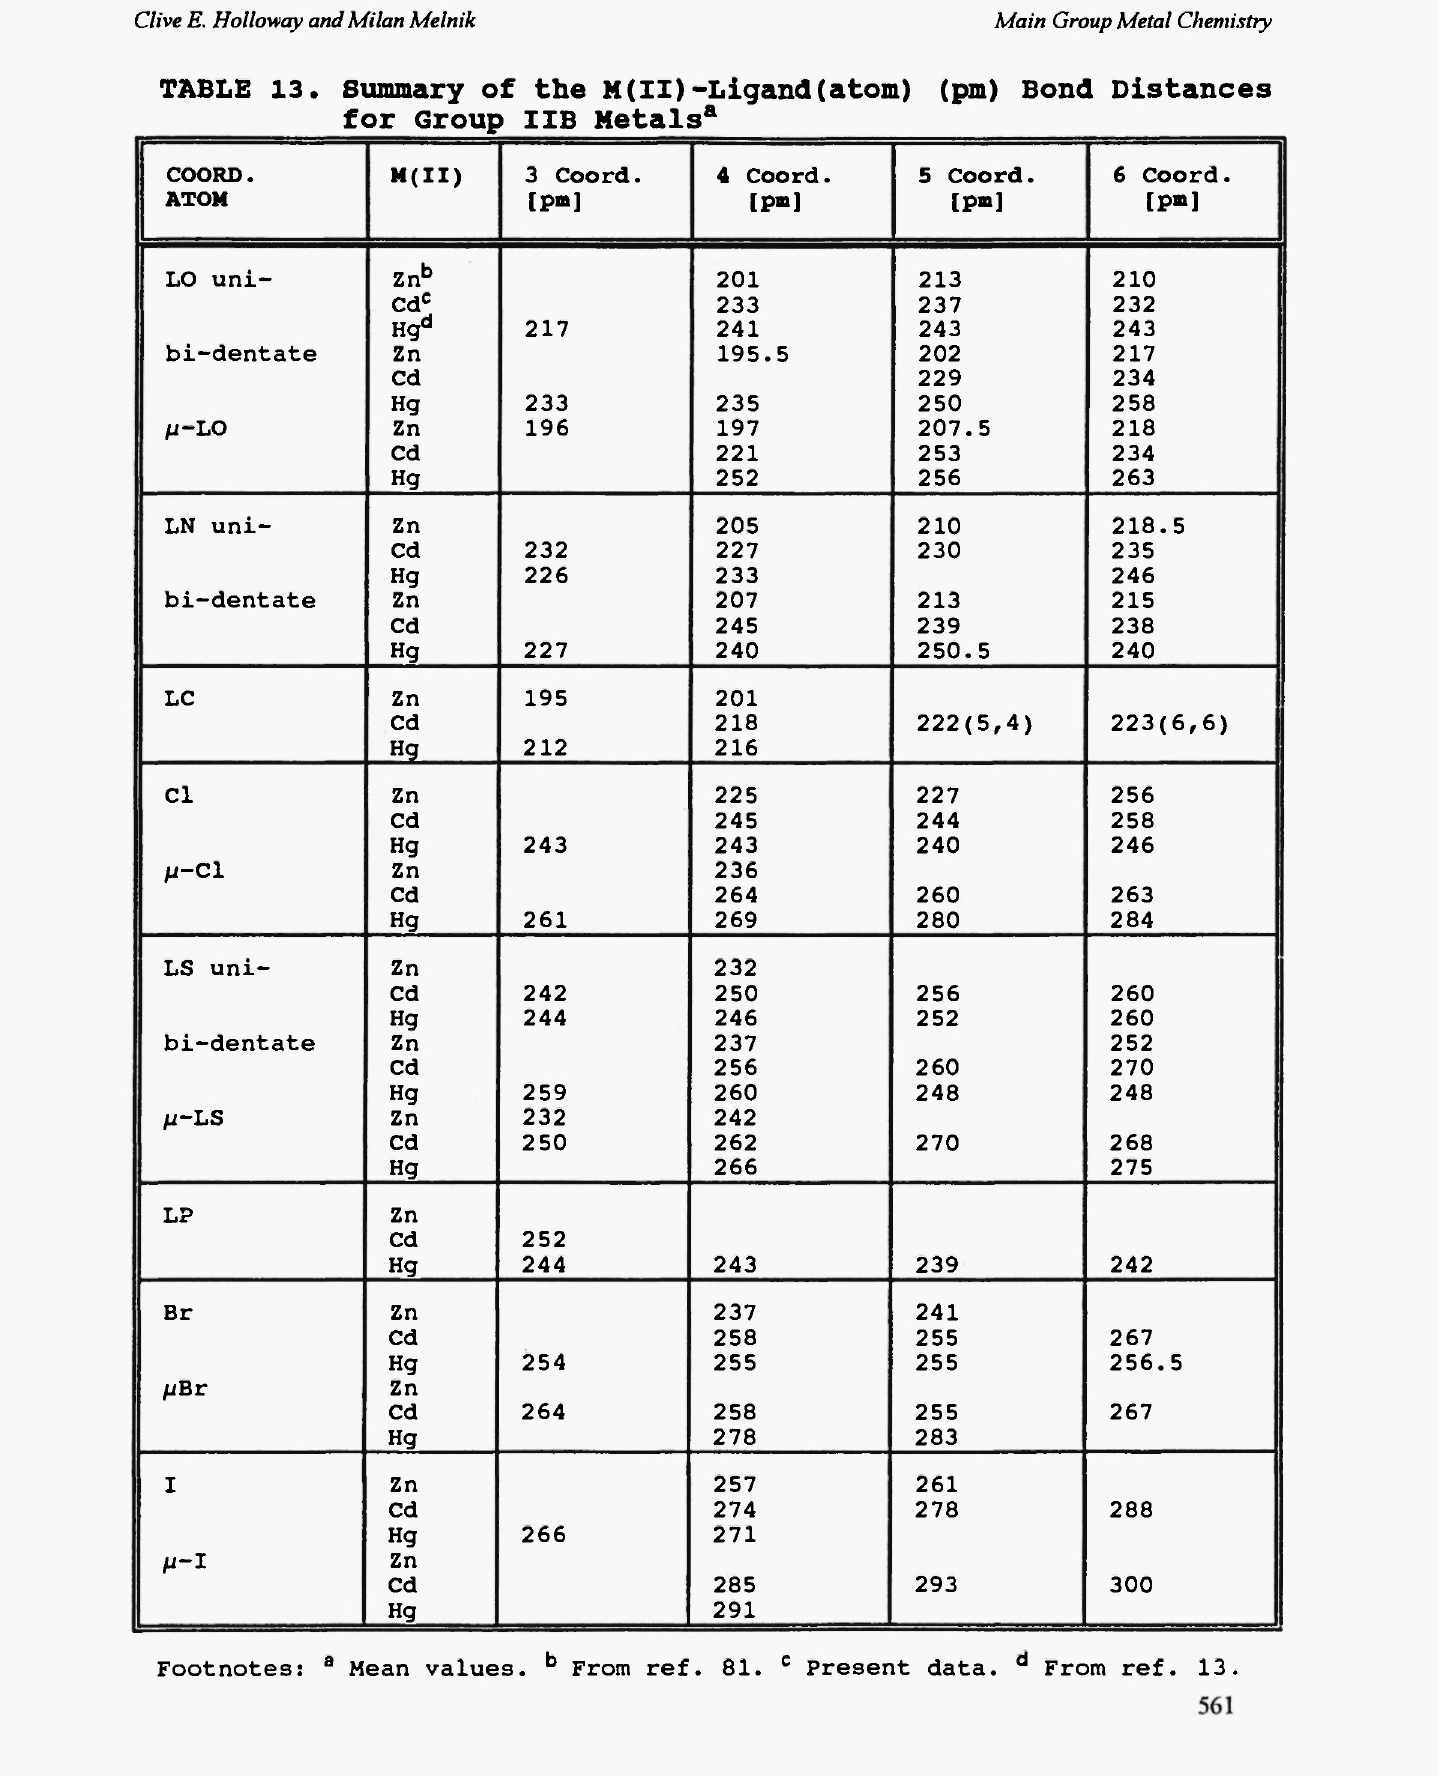
TABLE 13. Summary of the M(II)-Ligand(atom) (pm) Bond Distances for Group IIB